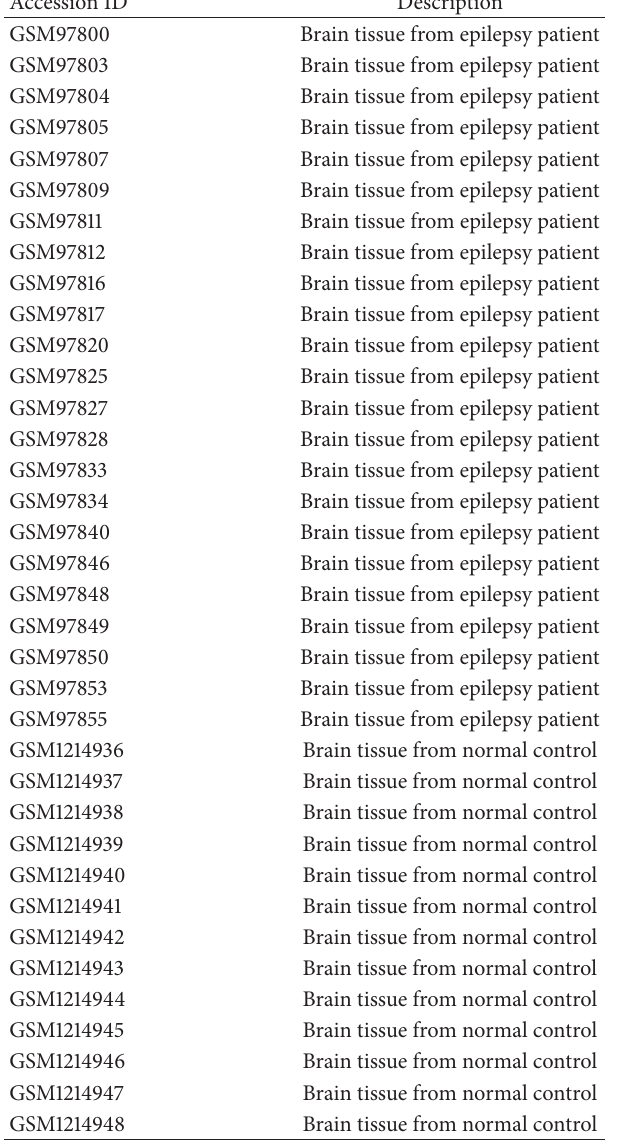
Table 1: Characteristics of the expression profile used in this